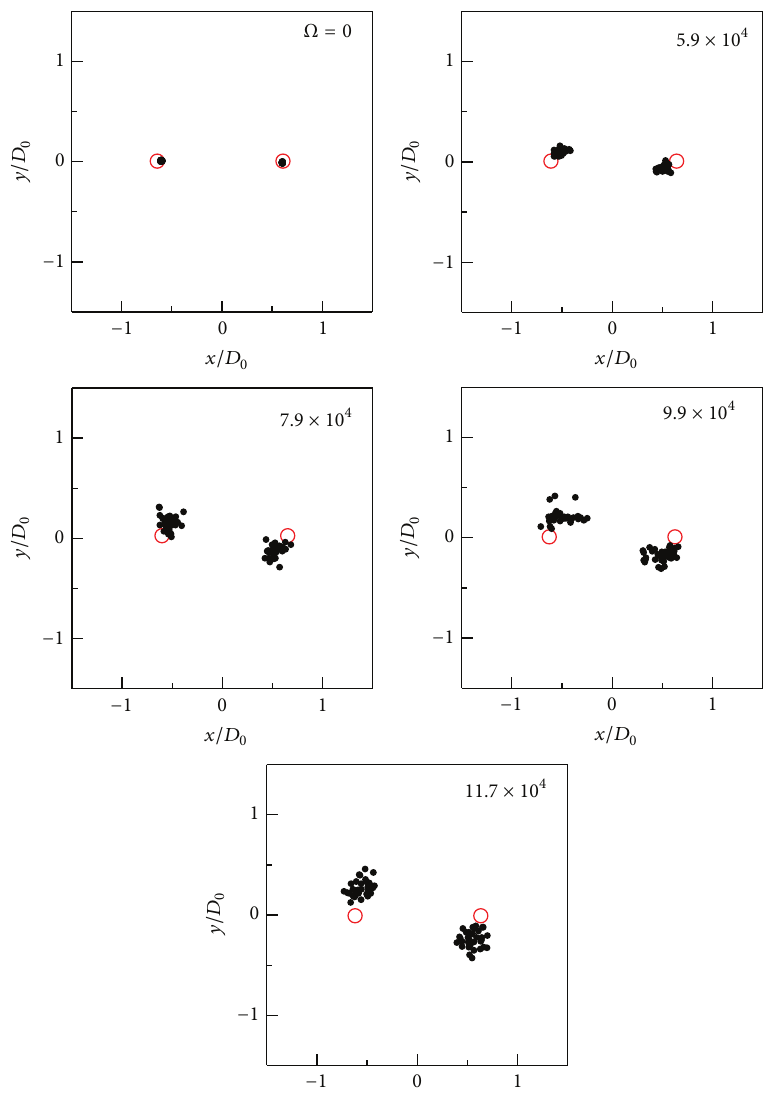
Figure 9: Bubble distribution over the horizontal section at 𝑧/𝐷 0 = 0.83 ( 𝑄 𝑔 = 24 mm 3